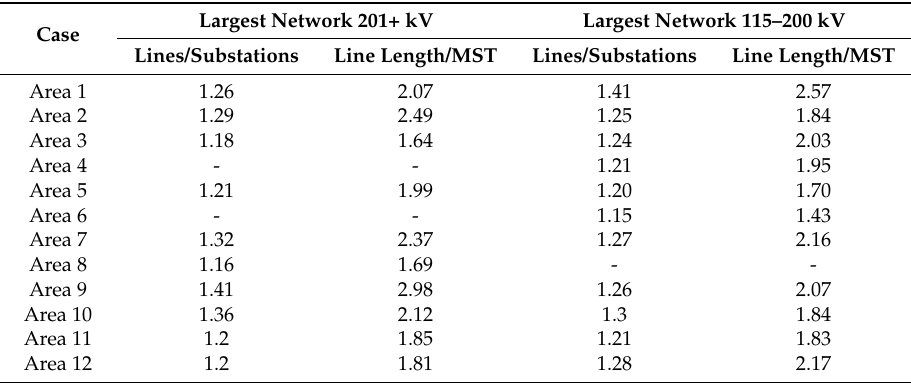
Table 5. Ratio of lines to substations and line length to minimum spanning tree (MST) at nominal voltage